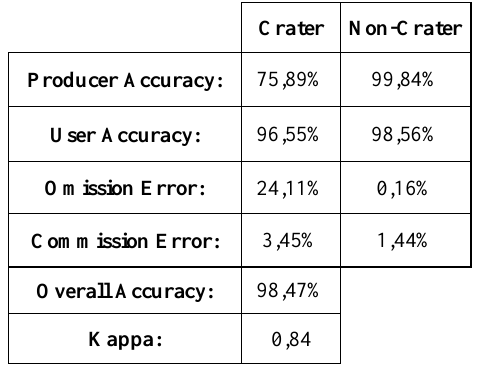
Table 5. Accuracy assessment of developed